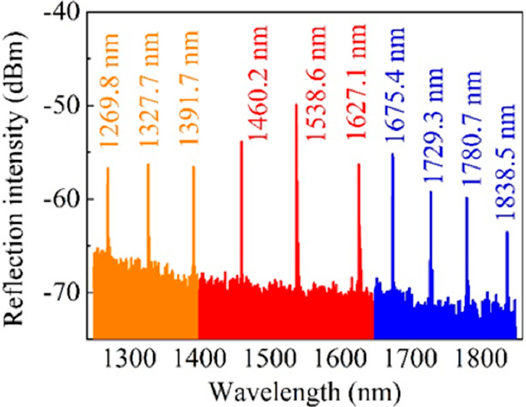
Figure 8. Reflection spectrum of an FBG array inscribed by the proposed Talbot interferometer without any compensating for the optical path difference (OPD). The central wavelength of inscribed FBG ranges from ~1269.8 to ~1838.5 nm.